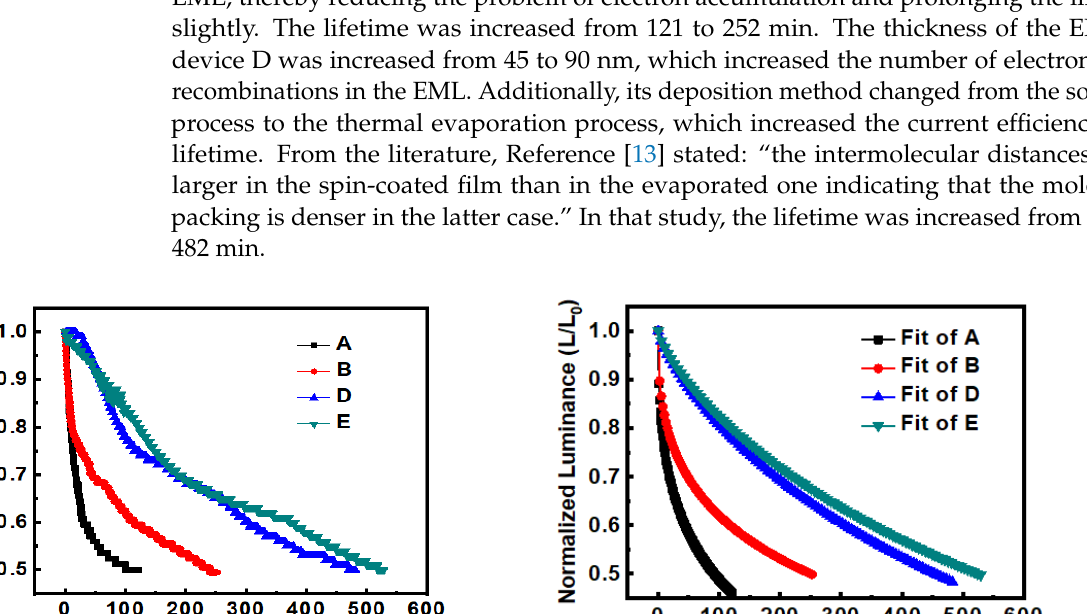
Figure 7. Comparisons of device lifetime ( a ) experimental data, ( b ) fit curves with the formula.